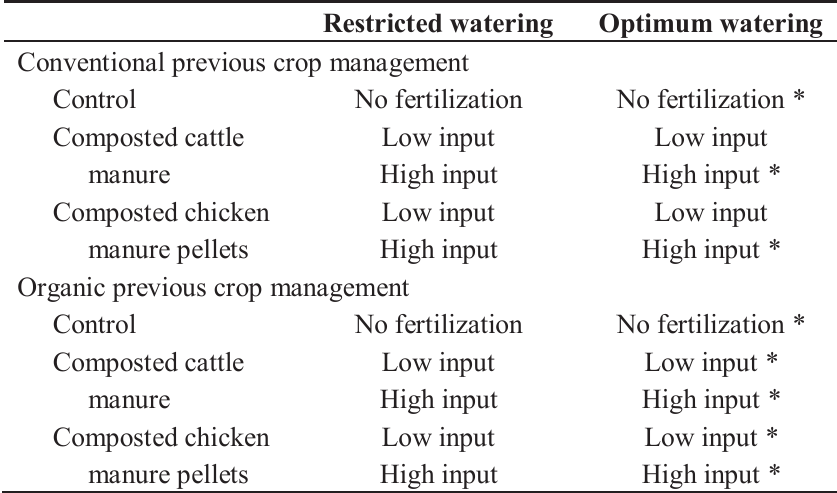
Table 2. Inputs of major nutrients applied (kg ha − 1 ) in composted cattle manure